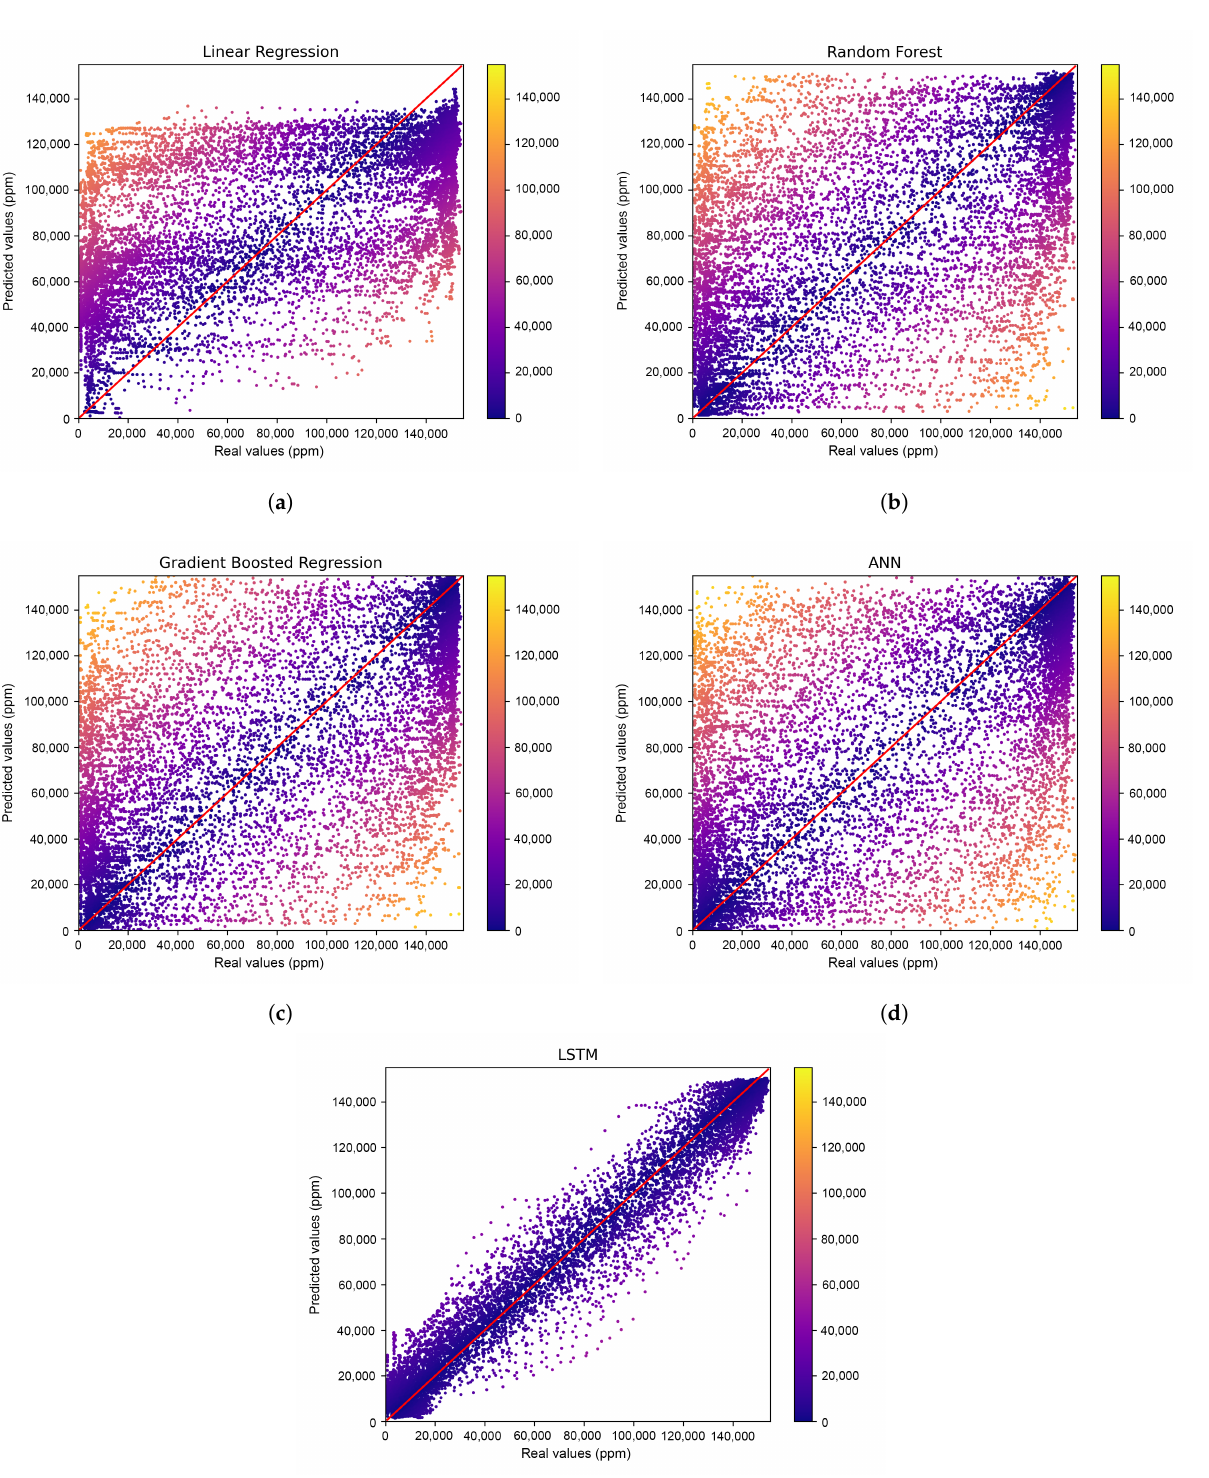
Figure 6. Prediction results. The colour-code is based on the difference between the original data and the predicted data. ( a ) Very dispersed predicted values with an R 2 of 42%. ( b ) Better prediction in ppm edges. Still high dispersion. ( c ) GBR still failing in predicting the CO 2 in switch-overs. ( d ) The ANN performed very poorly on power-train switch-overs, with an accuracy of 46%. ( e ) LSTM narrows all predictions to the ground